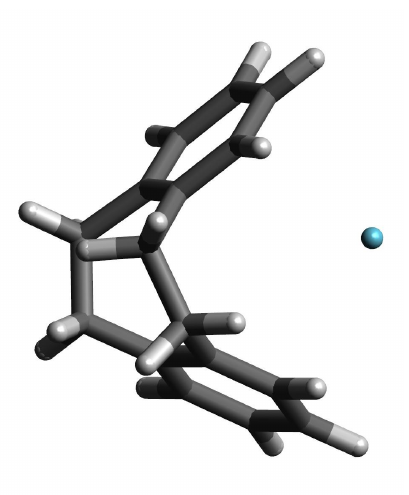
Figure 6. The structure of the [2 2 ](1,2)cyclophane · · · Kr complex.